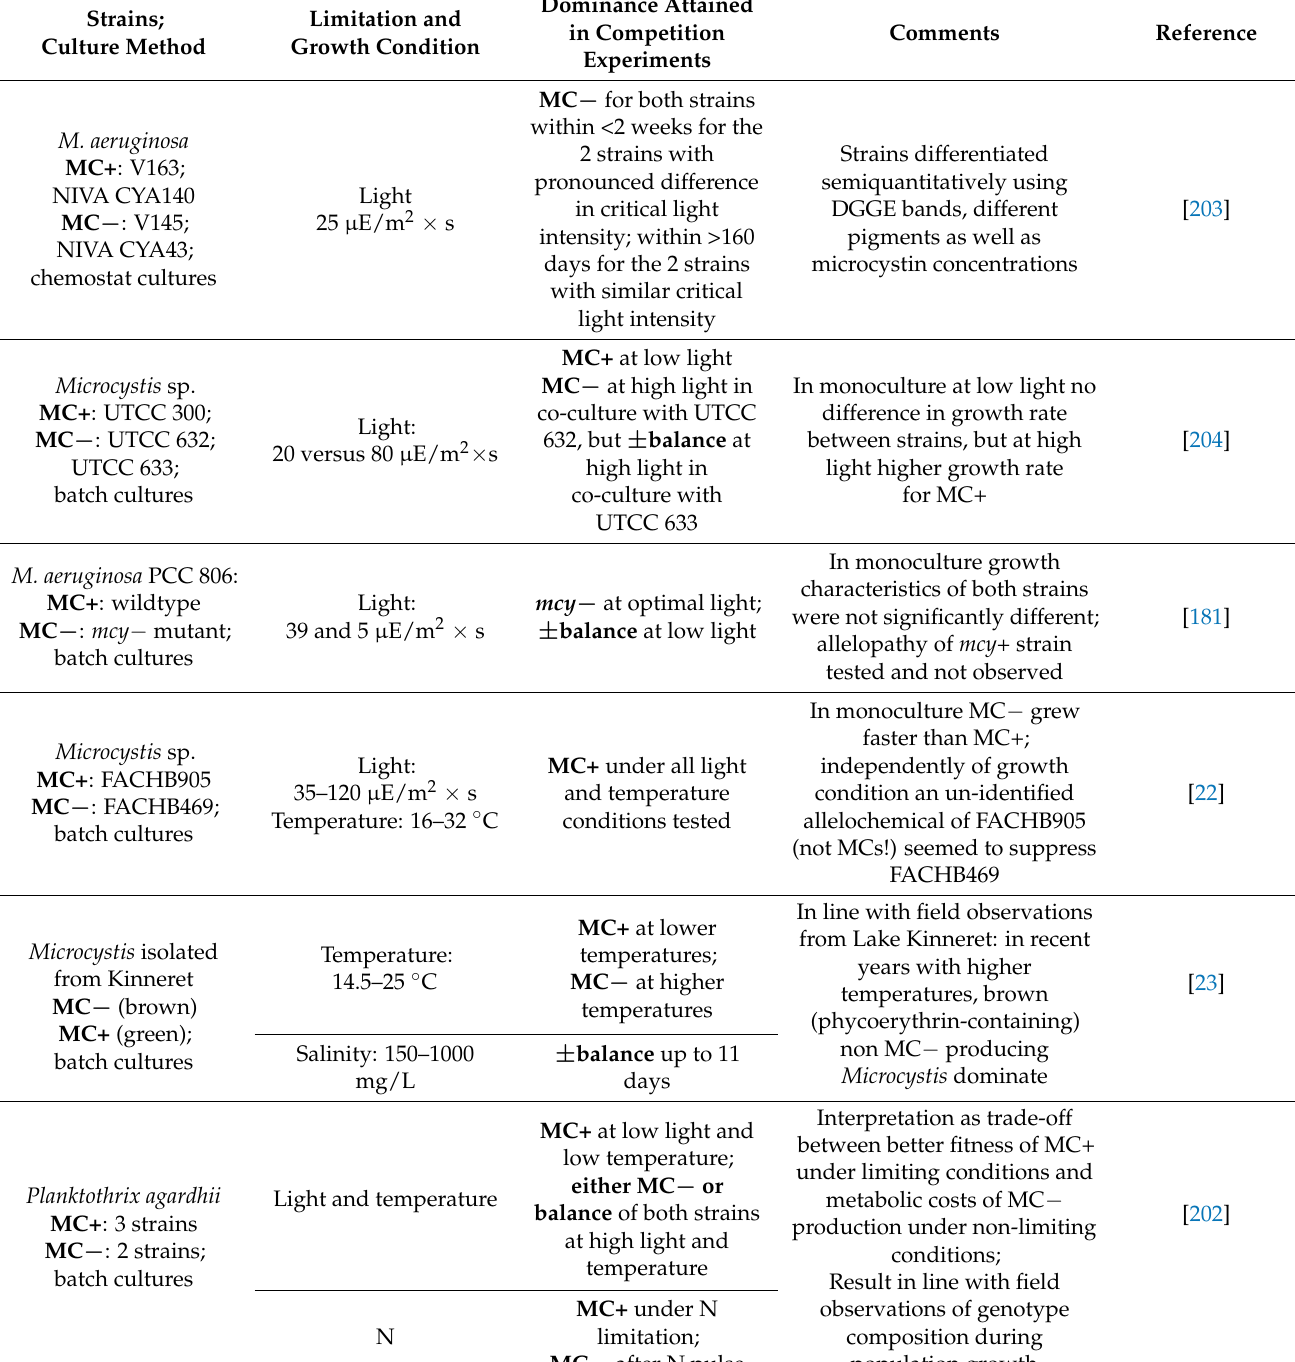
Table 1. Competition between strains: examples of outcomes of competition experiments between cyanobacterial strains with (MC+) and without (MC − ) microcystin production or pairs of wildtype ( mcy+ ) and knockout mutants ( mcy − ). The studies are organised by the limiting resource or growth condition, respectively (some studies occur